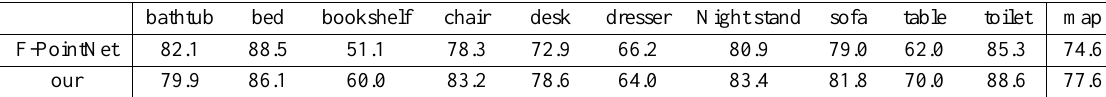
Table 3. 3D object detection AP on SUN-RGBD val